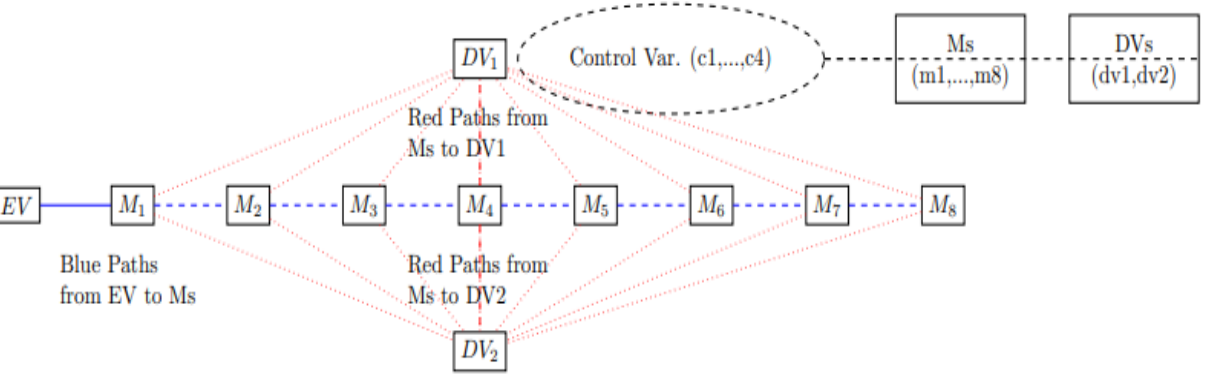
Figure 7. Mediation (path) model. A schematic diagram of the mediation structural equations model (SEM) which illustrates the hypotheses (source: own elaboration).